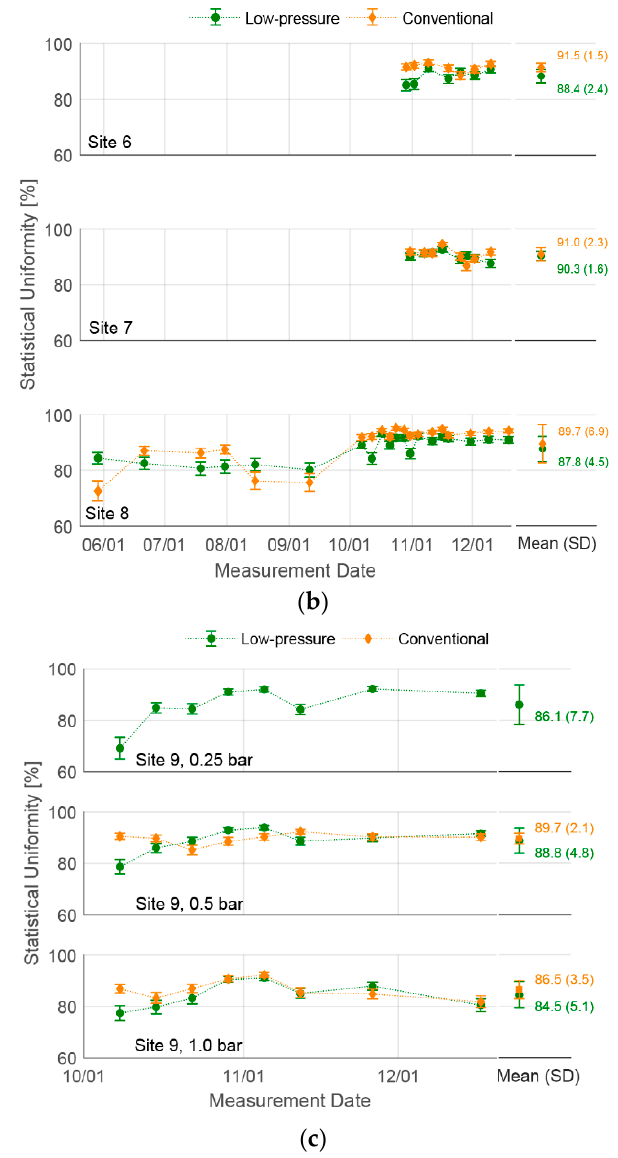
Figure 8. Statistical uniformity ( SU ) for all experimental plots in ( a ) Morocco sites (1–5); ( b ) Jordan freshwater sites (6–8); ( c ) Jordan wastewater site (9). Time series of uniformity over the season is shown, with the marker representing the measured SU for the sample size of 32 emitters per plot, and the error bars representing the standard error of the measurement. The seasonal means and standard deviations (in parentheses) are shown for each site as well. Low-pressure emitters have uniformities comparable to those of conventional emitters B in Jordan and slightly lower than those of conventional emitters A in Morocco.